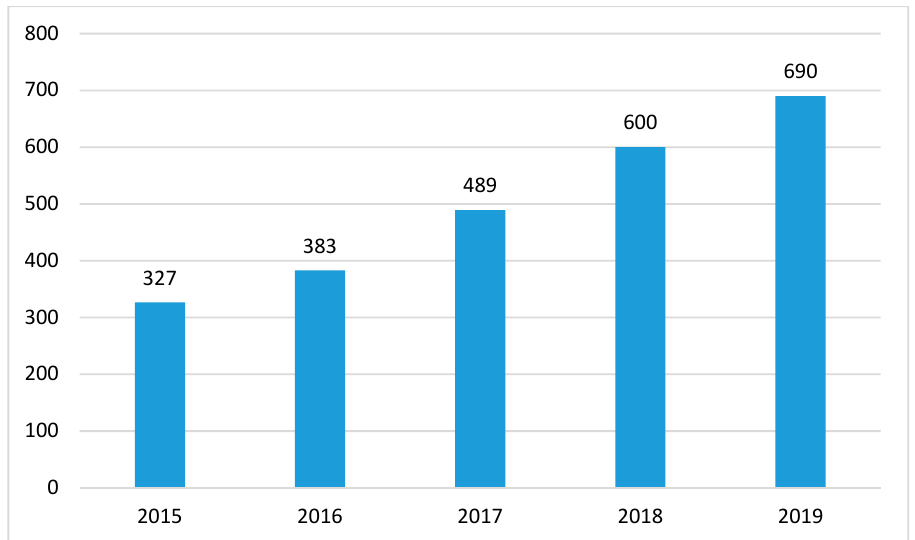
Figure 1. Number of articles per year ( n = 2489).